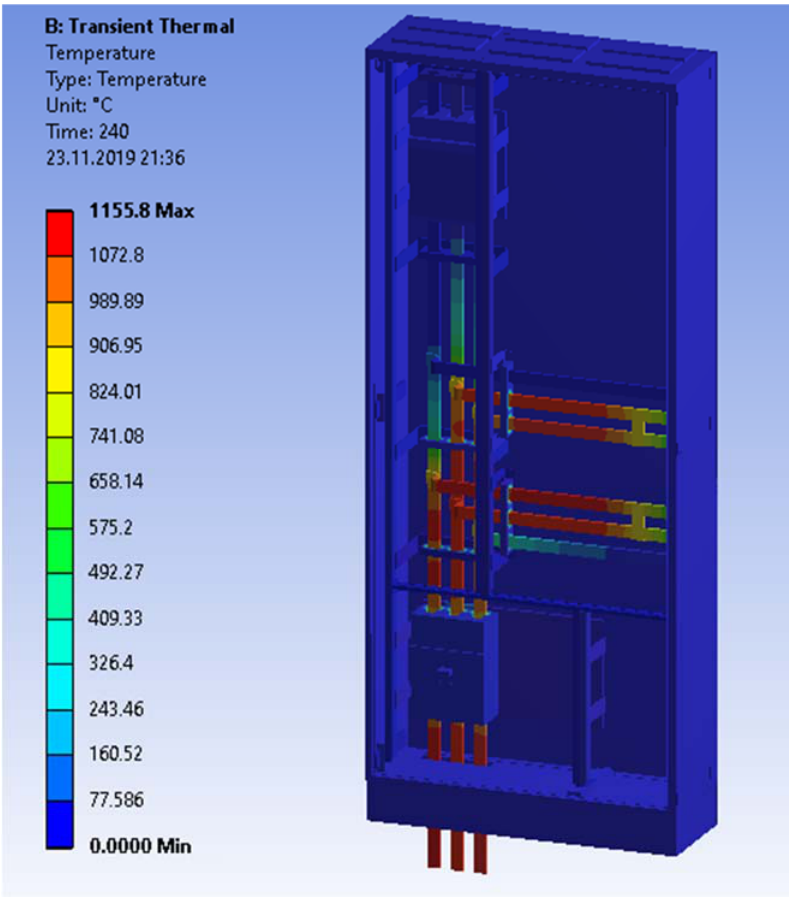
Figure 12. The convective distribution of heated air inside the switchgear in short-circuit conditions. For short-circuit simulation, validation was not executed because of the very high costs of experimentation measures. Those simulations are theoretical and should be treated as additional content for this work. Those may be validated in future